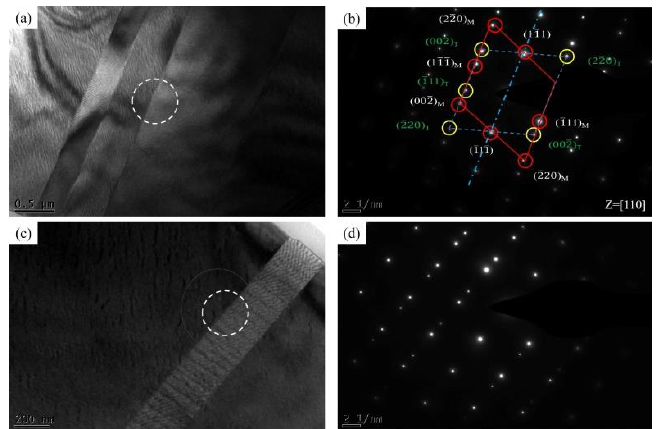
Figure 8. TEM and SAED of annealing twins under different annealing temperature: ( a ) 770 °C/15 min samples; ( b ) SAED of 770 °C/15 min samples; ( c ) 650 °C/15 min samples; ( d ) SAED of 650 °C/15 min samples.